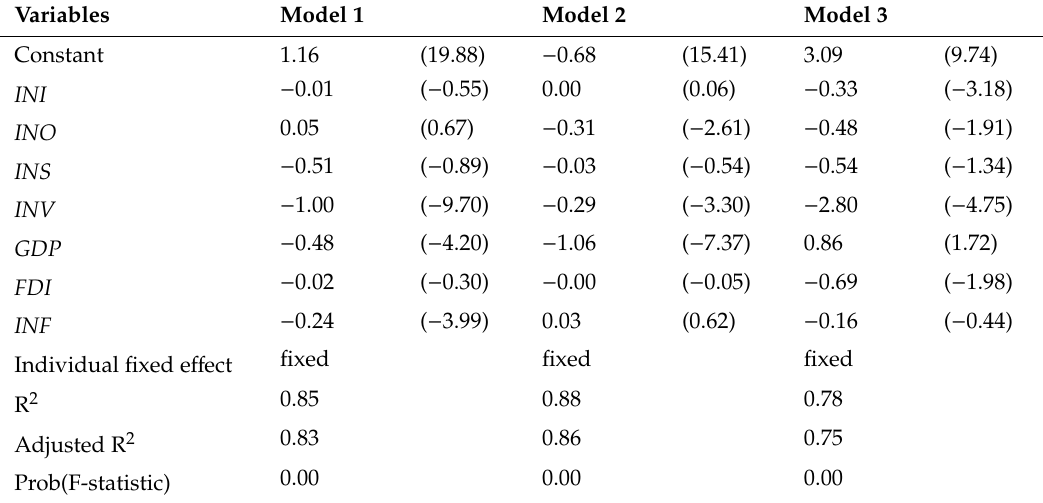
Table 3. Innovation-driven strategy and the impact on green economic development in smart cities after eliminating the four major